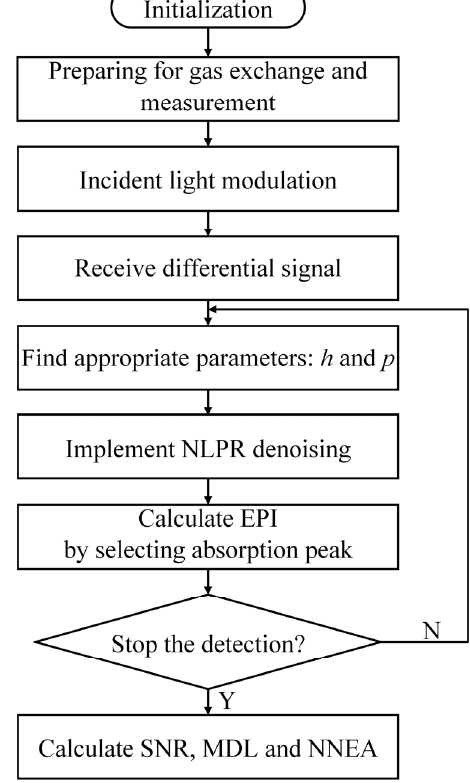
Figure 7. The main multi-component gas detection procedure based on NLPR algorithm-enhanced DFTIR-PAS configuration.